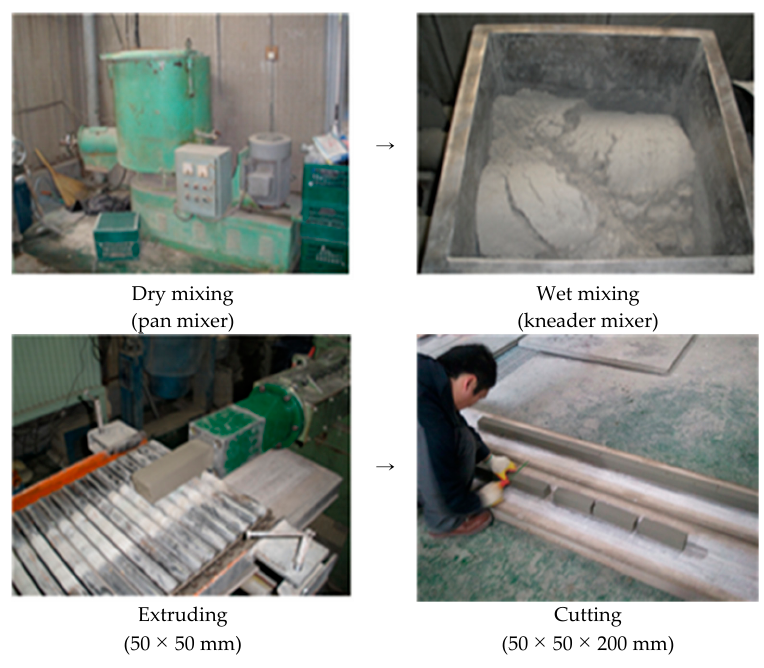
Figure 5. Experimental method.